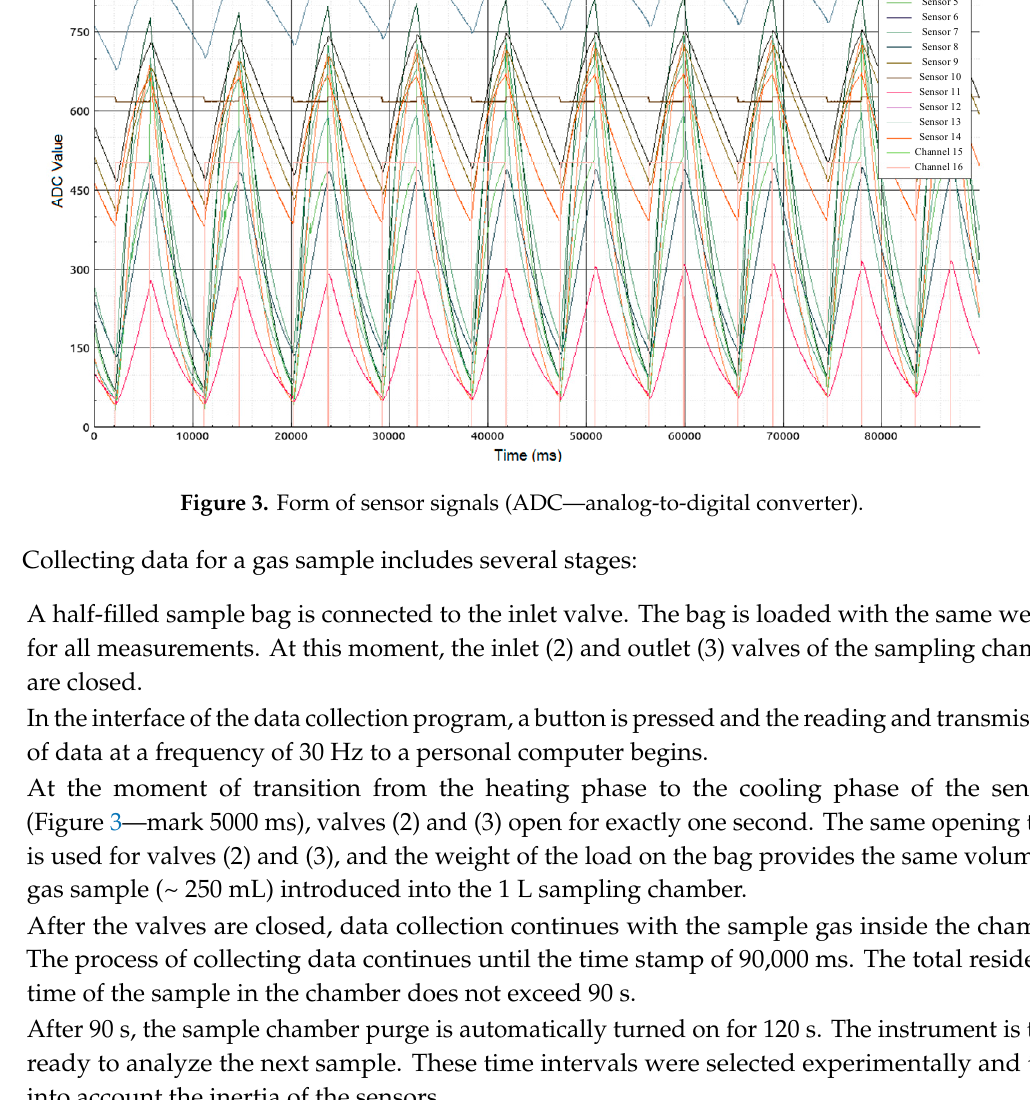
Figure 2. Generalized structure of the gas analytical system. Bold black arrows—gas flow; regular black arrows—control signal line; white circle—pump; dotted line box—sampling chamber; 1, 2 and 3—valves.